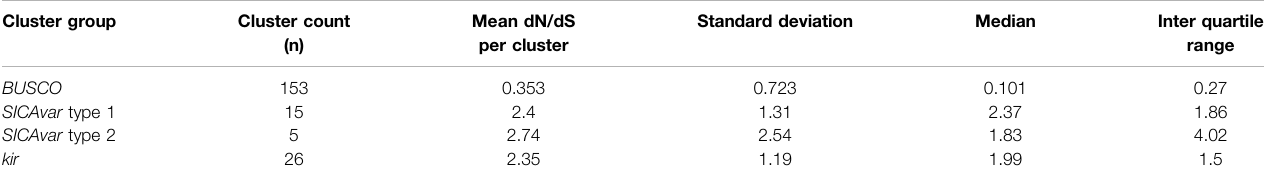
Legend to Table 5 : SICAvar type 1, SICAvar type 2, kir genes, and BUSCO (control groups) genes were translated into amino acid sequences and clustered into orthologous groups using OrthoFinder (Thorpe et al., 2018). The amino acid sequences were aligned and the alignments “ backtranslated ” into nucleotide coding sequences for subsequent dN/dS analysis using Codophyml (Gil et al., 2013). In order to avoid false-positive dN/dS results, the nucleic acid alignment was fi ltered to dis-allow gaps, insertions, and deletions, and the fi nal fi ltered nucleotide alignments with three or more sequences per cluster, the minimum requirement for Codophyml (Gil et al., 2013), were subjected to